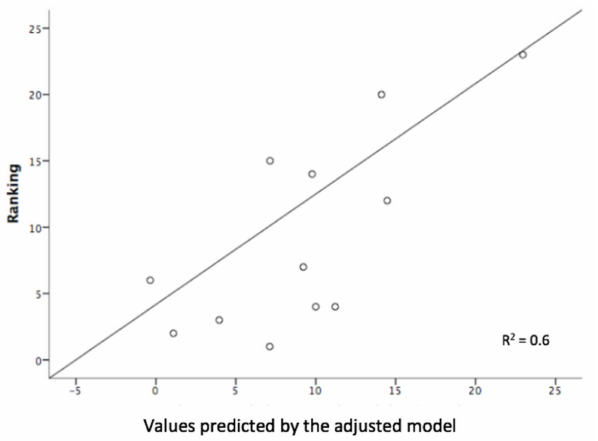
Figure 2. Fitted linear regression graph of model 2 for the Windsurfing group. Method of successive steps. Variables: age and sailing